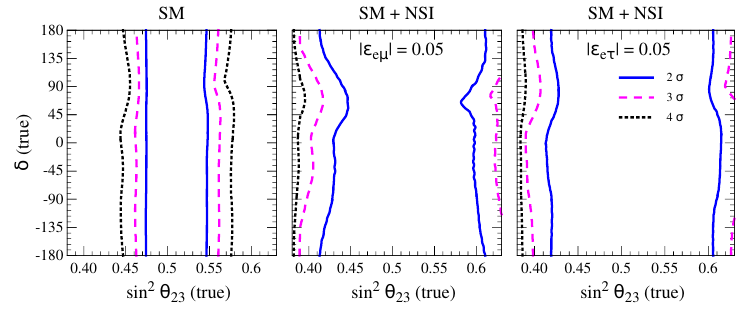
Figure 19.2: Discovery reach of the octant θ assuming NH as true choice. The left, 23 | = 0.05 and SM + NSI middle and right panels correspond to SM, SM + NSI with | (cid:34) e µ | = 0.05 cases respectively. In the SM case, we have marginalized away with | (cid:34) e τ ( θ , δ ) (test). The solid blue, dashed magenta, and dotted black curves depict 23 the 2 σ , 3 σ , and 4 σ confidence levels (1 d.o.f.) discovery reach. In SM, we have marginalized over CP-phase δ and θ (opposite octant), while in SM + NSI cases, in 23 addition, we have marginalized over the true and test values of the NSI CP-phases ( φ ( φ ) in the middle (right) panel respectively. For more details please see [ 35 ] . e µ e τ This figure has been taken from [ 35 ]